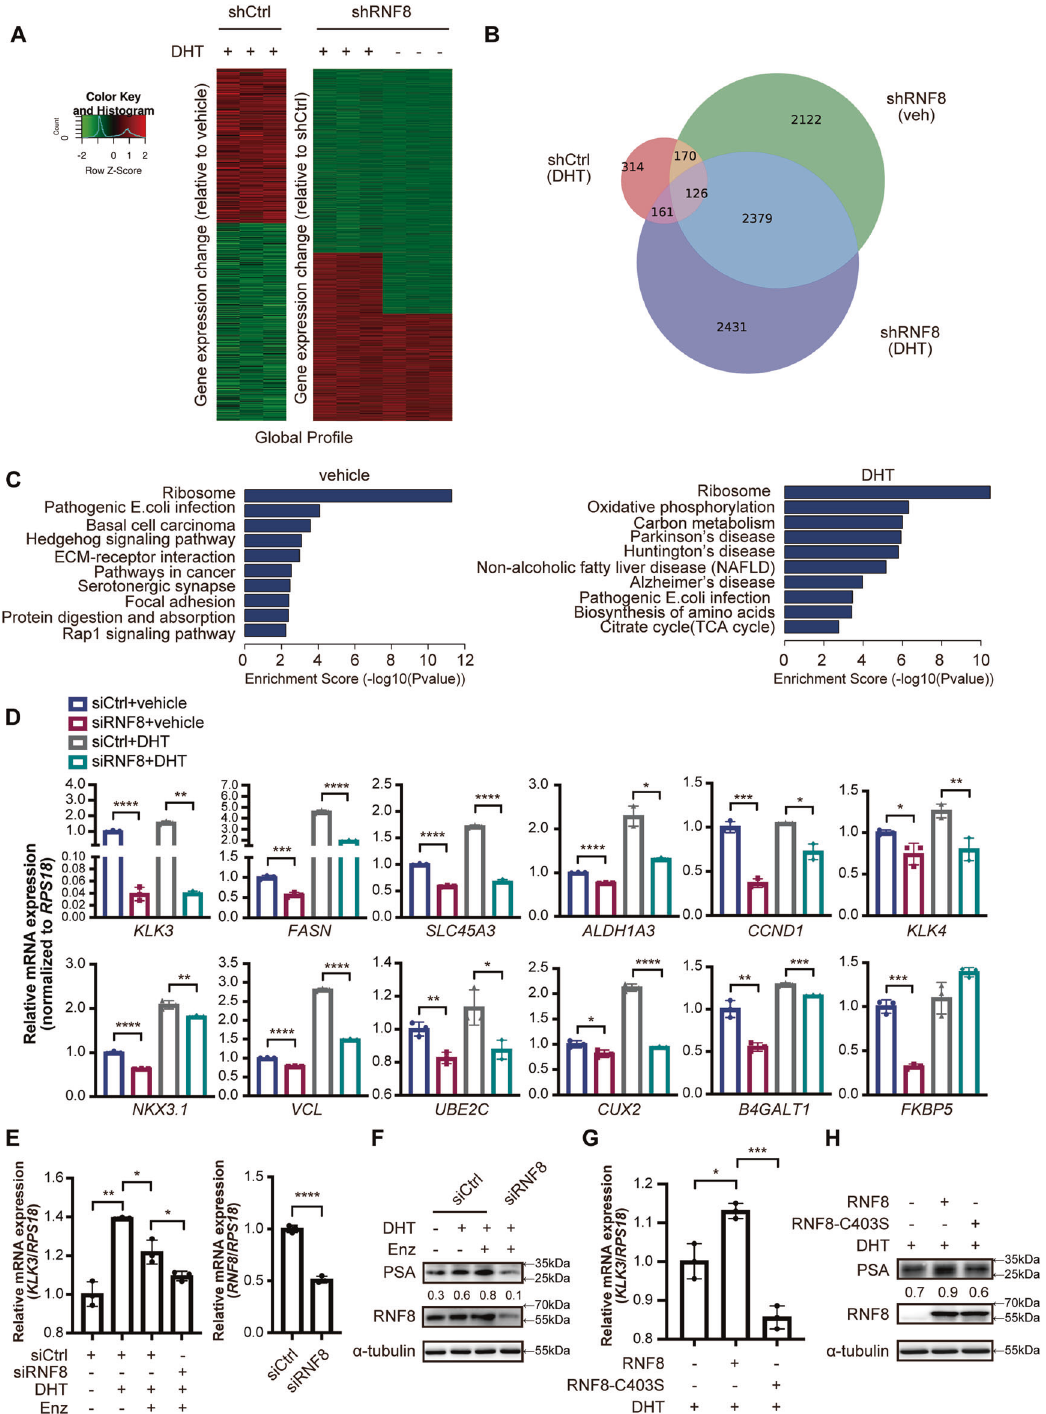
Fig. 5 RNF8 upregulates the transcription of endogenous AR target genes in prostate cancer cells. A mRNA-seq analysis pro fi le of control and RNF8 silencing 22Rv1 cells treated without or with DHT (10 − 8 M) for 24 h. The heat map displays gene expression change of DHT-induced genes upon RNF8 knockdown. Fold change is indicated as left. B Venn diagram showed DHT-regulated genes in shCtrl and shRNF8 cells in the absence or presence of DHT (10 − 8 M). C Biological processes of DHT-induced transcripts impacted by RNF8 knockdown without or with DHT (10 − 8 M) treatment as revealed by KEGG pathway analysis. D The transcription levels of indicated genes in control or RNF8 silencing 22Rv1 cells treated without or with DHT (10 − 8 M) for 24 h ( n = 3). E , F The mRNA and protein levels of KLK3 (PSA) in control or RNF8 silencing 22Rv1 cells with the vehicle, DHT (10 − 8 M) or enzalutamide (10 µM) treatment for 24 h. G , H The mRNA and protein levels of KLK3 (PSA) in 22Rv1 cells transfected with Flag-RNF8 or Flag-RNF8C403S treated with DHT (10 − 8 M) for 24 h ( n = 3). Data of the qRT-PCR were presented as the ratio normalized to RPS18 (means ± SEM). * P < 0.05; ** P < 0.01; *** P < 0.001; **** P < 0.0001 (two-sided unpaired t -test). Numbers below the western blot result indicate the relative gray value normalized to the internal control ( α -tubulin).